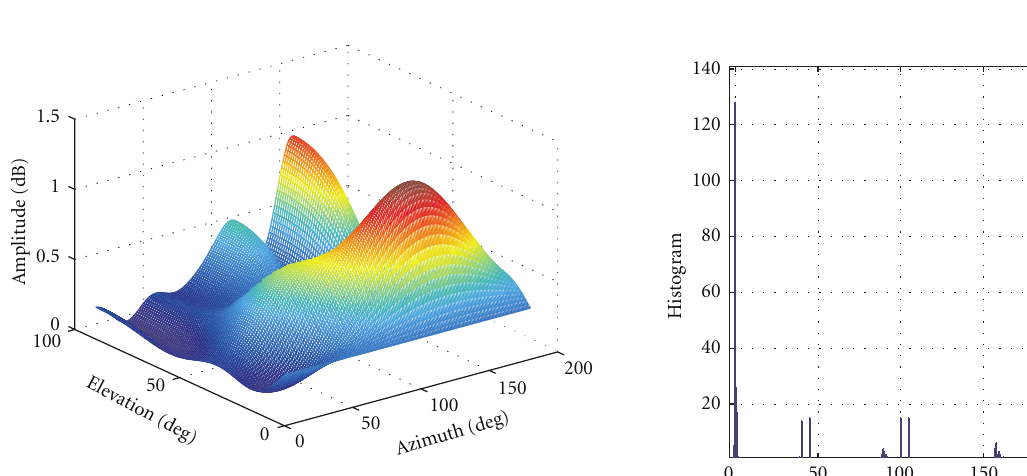
Figure 5: MUSIC pseudospectrum for ideal case where the e ff ect of mutual coupling is ignored.